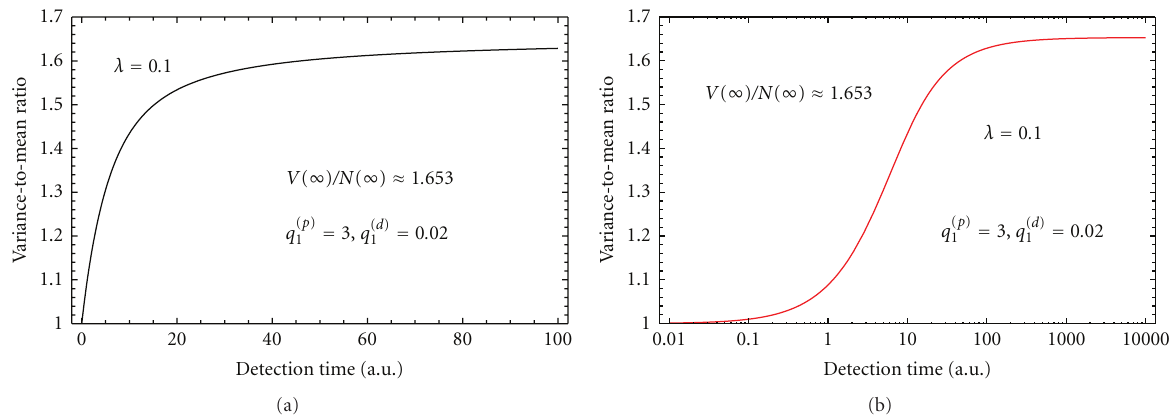
Figure 5: Dependence of the ratio of the variance to mean of the number of F types particle detections on the detection time u . The left-hand side figure shows the linear-linear, while the right-hand side one the log-linear